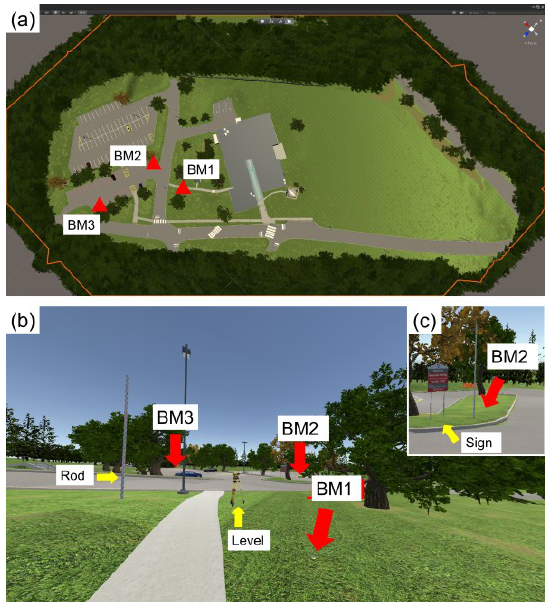
Figure 8. (a) top view of the virtual environment showing the benchmark locations of the leveling loop lab; (b) side view showing the benchmark locations, the differential level instrument, and leveling rod; (c) screenshot showing the sign next to benchmark 2.